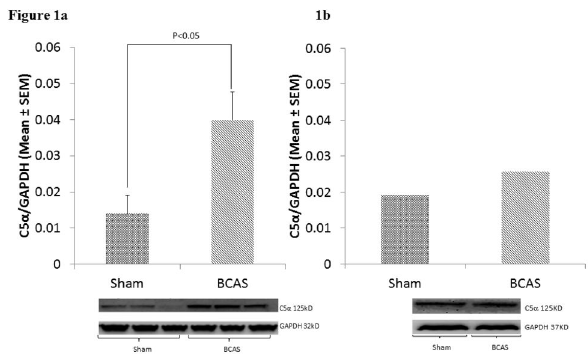
Figure 1. C5 deposition by Western blot Analysis. C5α levels in sham and BCAS mice at thirty days in A) whole brains and B) corpus callosum homogenates. Bottom: Western Blots. Top: Relative C5α densities represented graphically (mean±SEM). Error bars are not presented in Figure 1b, as homogenates of three separate corpus callosum samples are combined into a single sample for each group (due to relatively small amount of tissue obtained from each corpus callosum dissection, n=3 for whole brain, n=3 for corpus callosum homogenates).